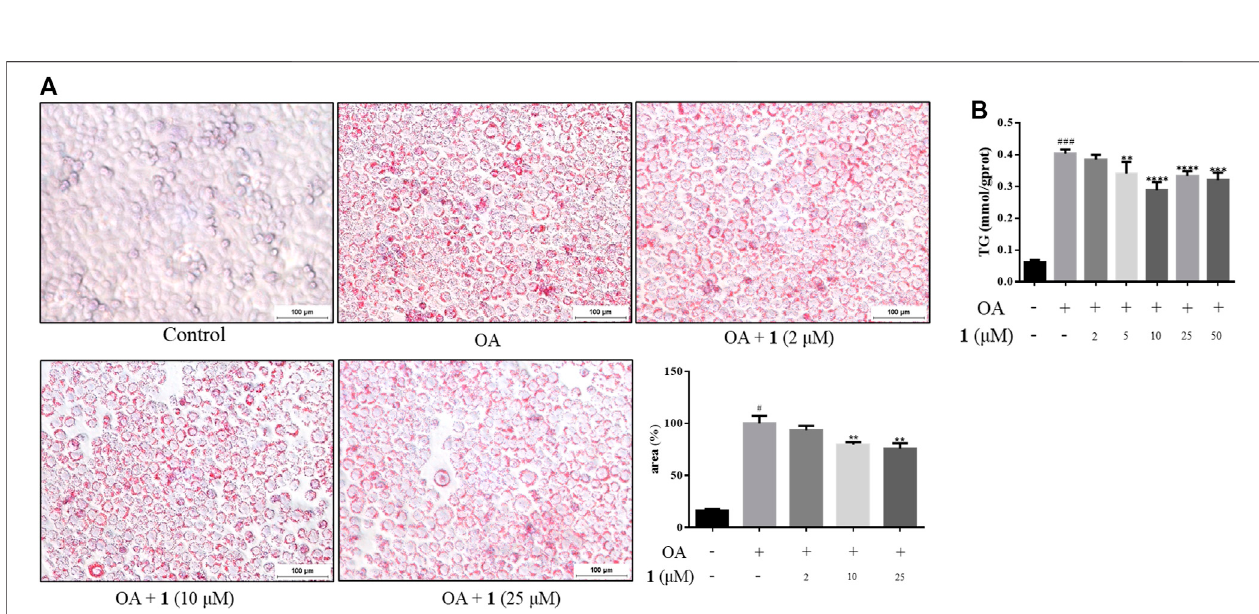
FIGURE 2 | (+)-Dehydrovomifoliol alleviates OA-induced excessive lipid accumulation in HepG2 cells. HepG2 cells were pretreated for 30 min with different concentrationsofcompound 1 andthenstimulatedwith10 μ Moleicacid(OA).Then,at24 hpost-treatment (A) OilredOstainingimages(100 × )andthepercentagesof HepG2 cells containing lipid droplets. (B) TG contents were analyzed using the TG detection assay. Data shown in the bar chart are expressed as the mean ± SEM ( n (cid:2) 3). # p < 0.05, # # # p < 0.001 vs the control group; * p < 0.05, ** p < 0.01, *** p < 0.001, **** p < 0.0001 vs the OA-induced group.